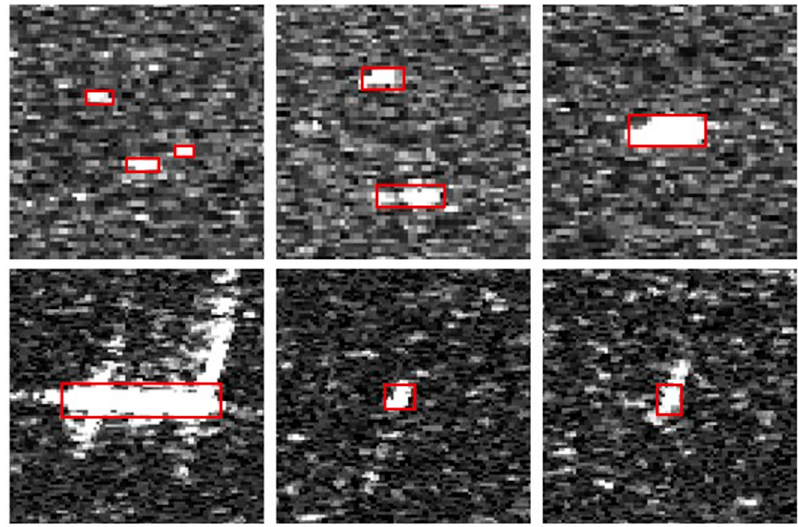
Figure 2. Samples of training objects’ bounding boxes, icebergs in top row and ships in bottom row. The targets are shown in single-polarization greyscale, HH (top) and VH (bottom).